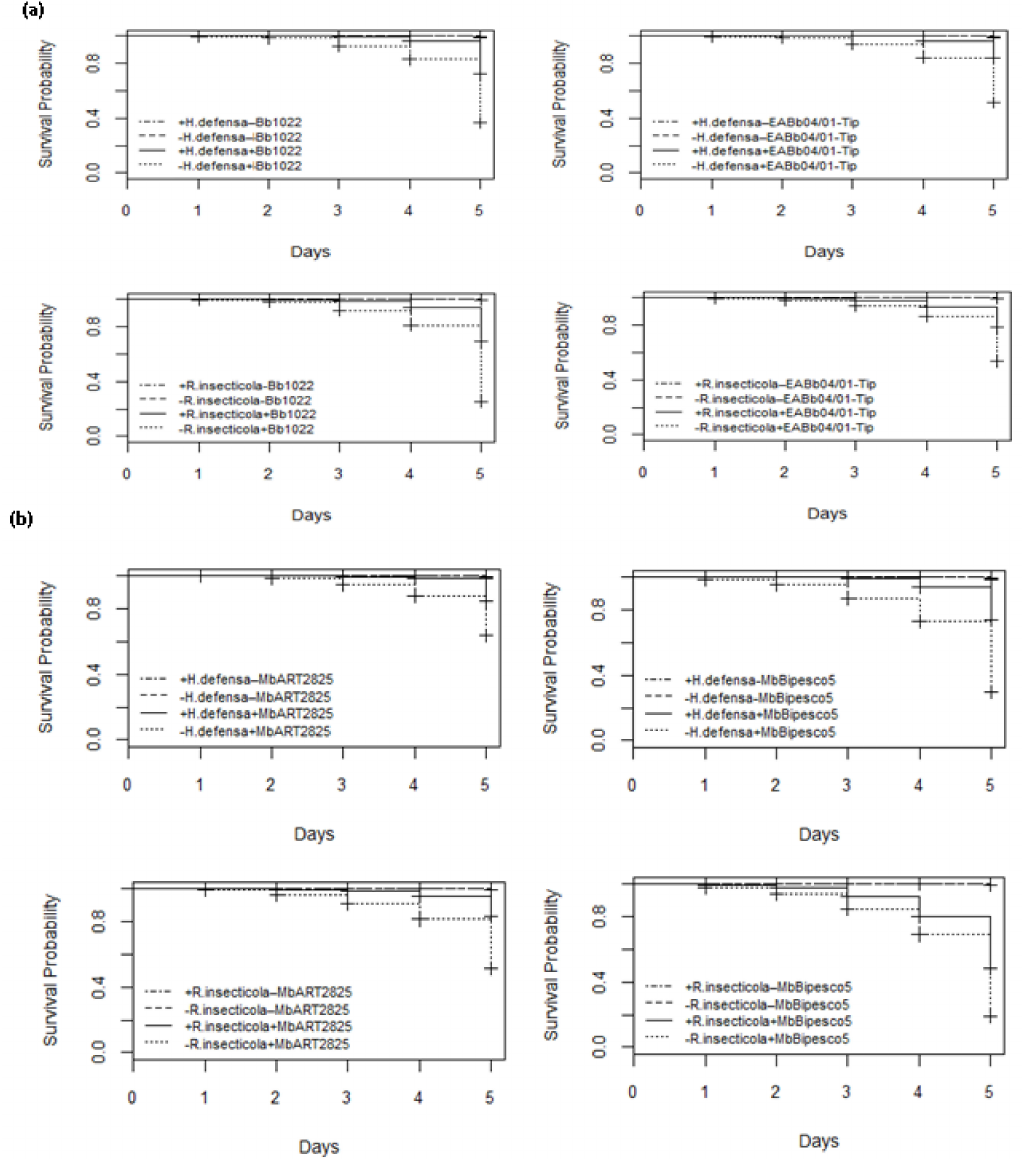
Figure 3. Survival curves showing infection period over 5 days post-application of entomopathogenic fungi Beauveria bassiana strains Bb1022 and EABb04/01-Tip ( a ) and Metarhizium brunneum strains ART 2825 and BIPESCO 5 ( b ) against wheat aphid ( Sitobion avenae ) clones +5, − 5, +7, and −